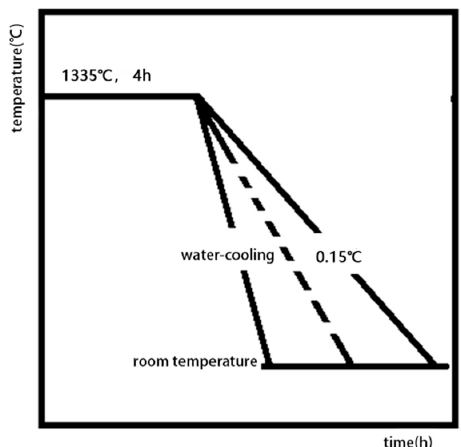
Figure 3. Cooling process.